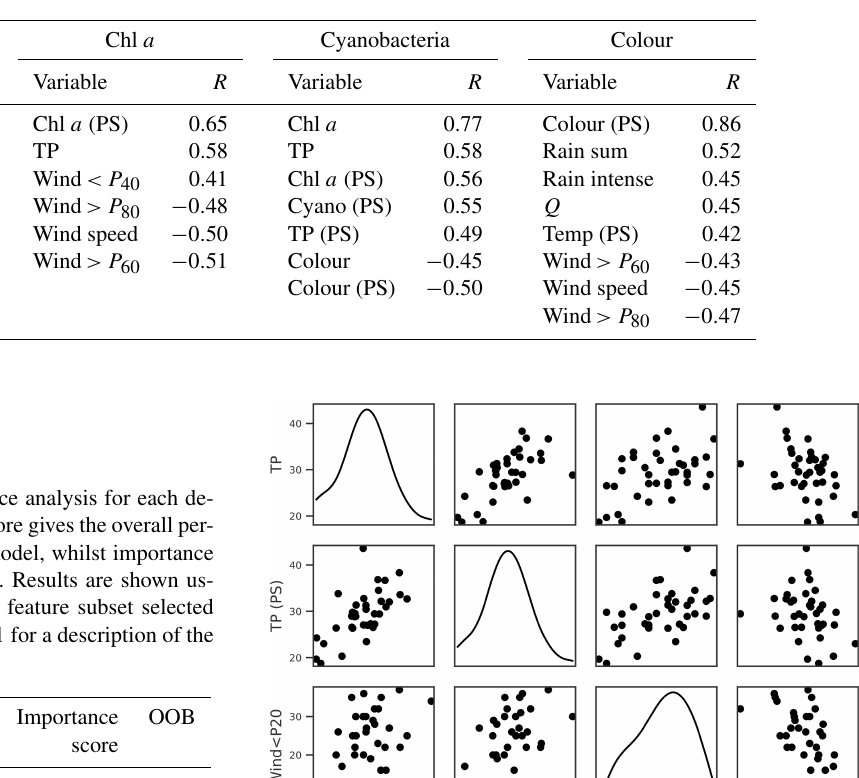
Table 3. Ranked Pearson’s correlation coefficients ( R ) for the four dependent variables (for clarity only | R | > 0 . 40 are shown). See Table 1 for a description of the variables.